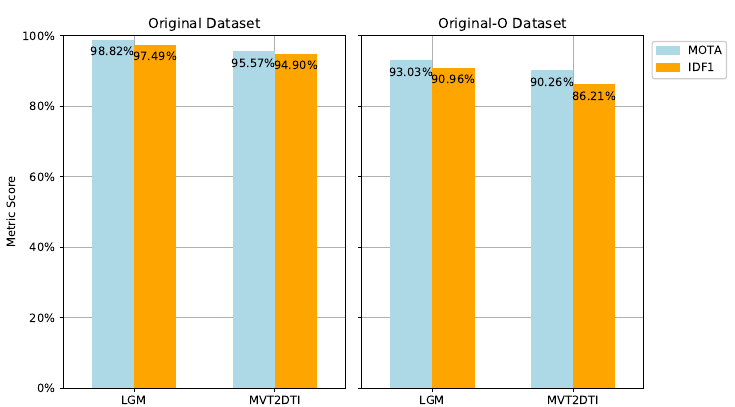
Figure 9. Performance comparison of LGM and